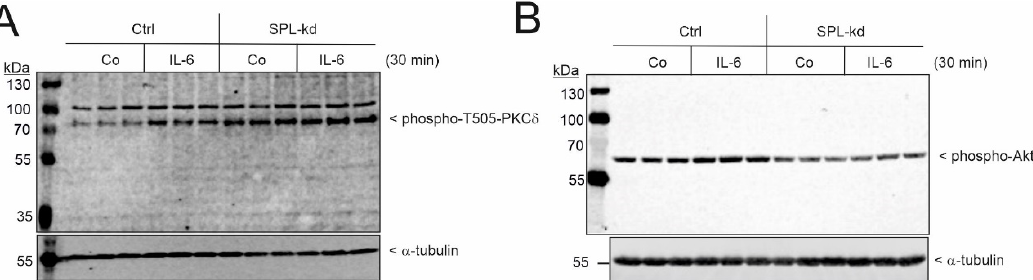
Figure 6. The effect of IL-6 on the phosphorylation and activation of PKC δ and Akt in Ctrl and SPL-kd podocytes. ( A ) Control transduced podocytes (Ctrl) or SPL-kd podocytes were treated for 30 min with either the vehicle (Co) or IL-6 (20 ng/mL). Protein extracts were taken for protein separation by SDS-PAGE, transferred to nitrocellulose, and subjected to Western blot analysis using antibodies against phospho-T 505 -PKC δ ( A , upper panel), phospho-S 473 -Akt ( B , upper panel), and α -tubulin ( A , B , lower panels). The data show representative blots in triplicates. The corresponding bands were evaluated using ImageJ software and are depicted in Supplementary Figure S6.